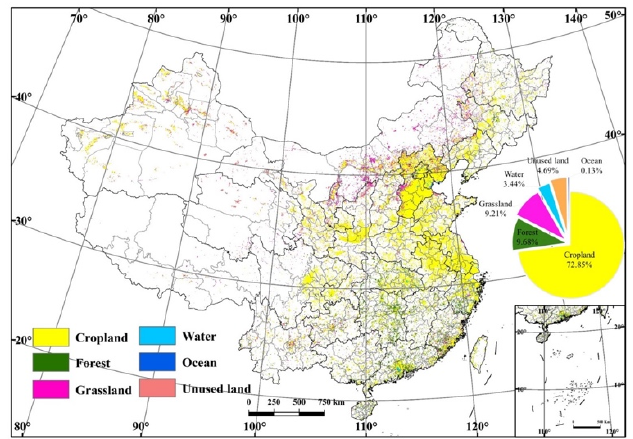
Figure 6. Spatial distribution of land use types converted to urban lands. Displayed by land use type with the largest proportion in 3 × 3 km pixels.